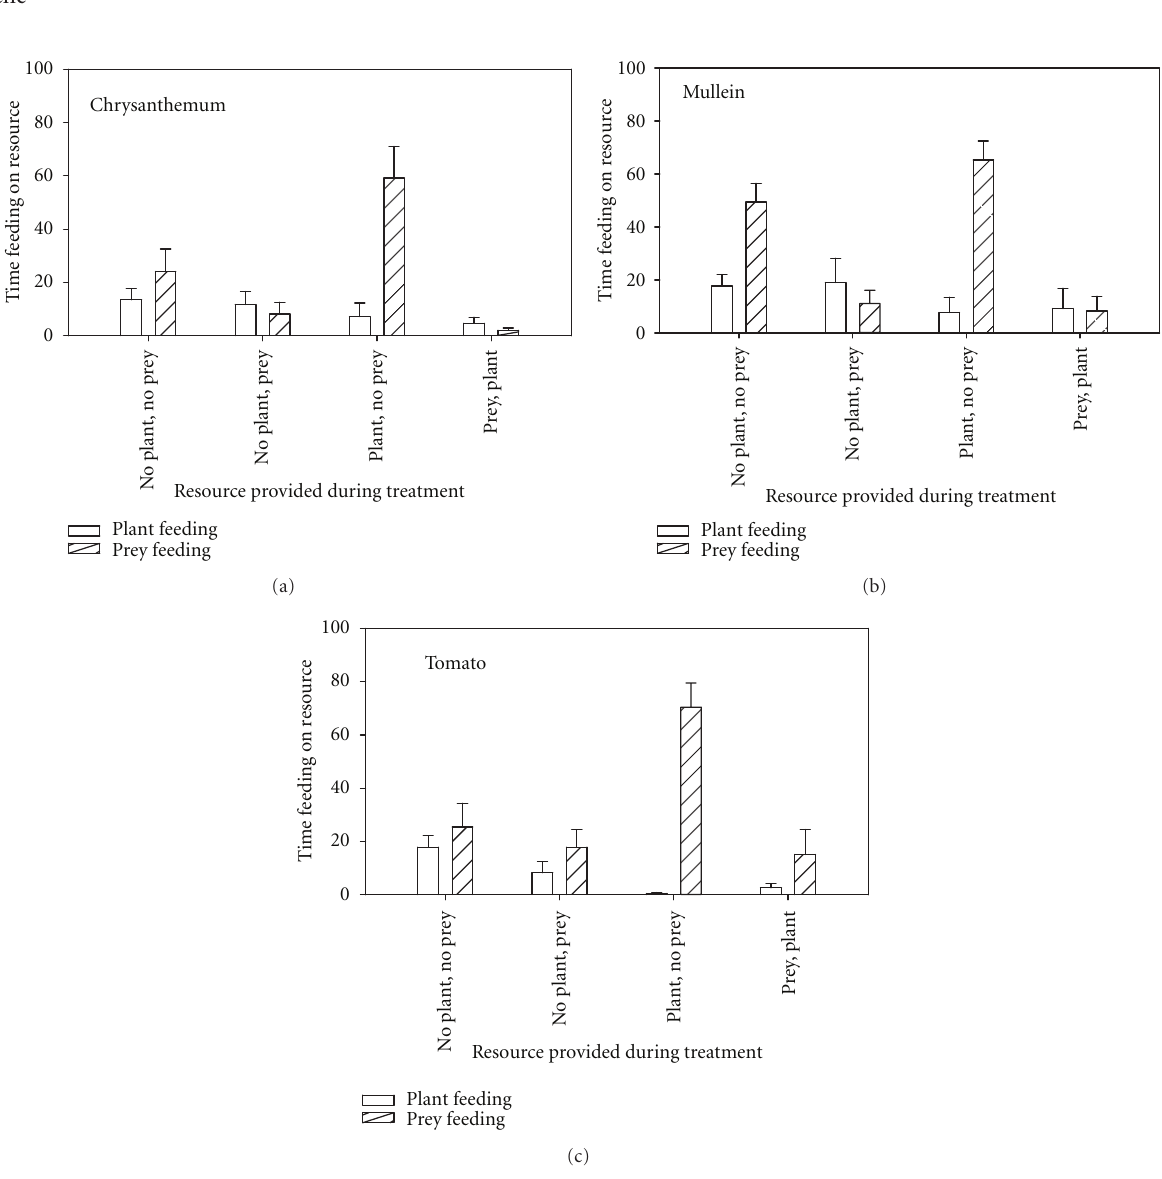
punctures on fruit on whole tomato plants ( F 2,27 = 8 . 12, P